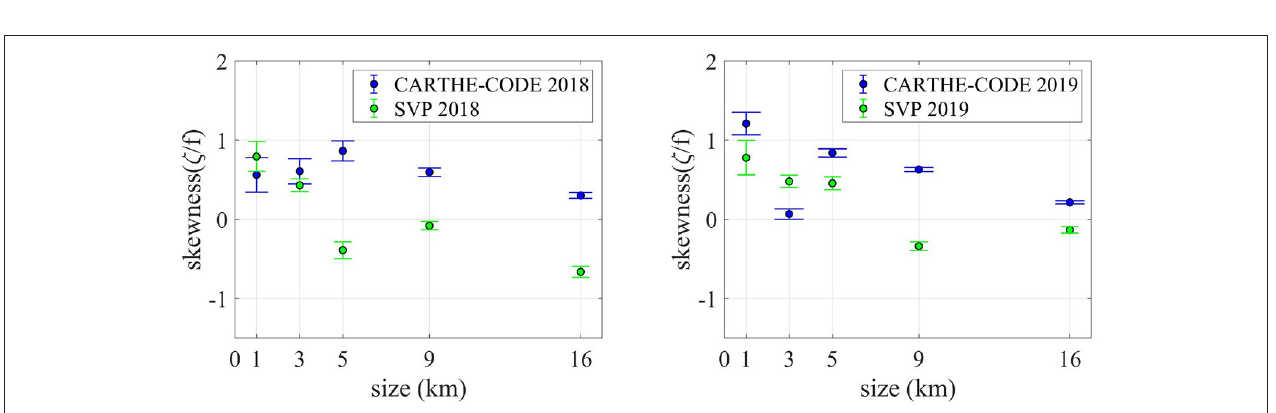
FIGURE 8 | Scale dependence of rms values of normalized divergence (upper) and vorticity (lower) for the experiments 2018 (left) and 2019 (right) for the surface drifters (CARTHE and CODE) in blue and 15 m drifters (SVP) in green. Error bars indicate 95 % CI.